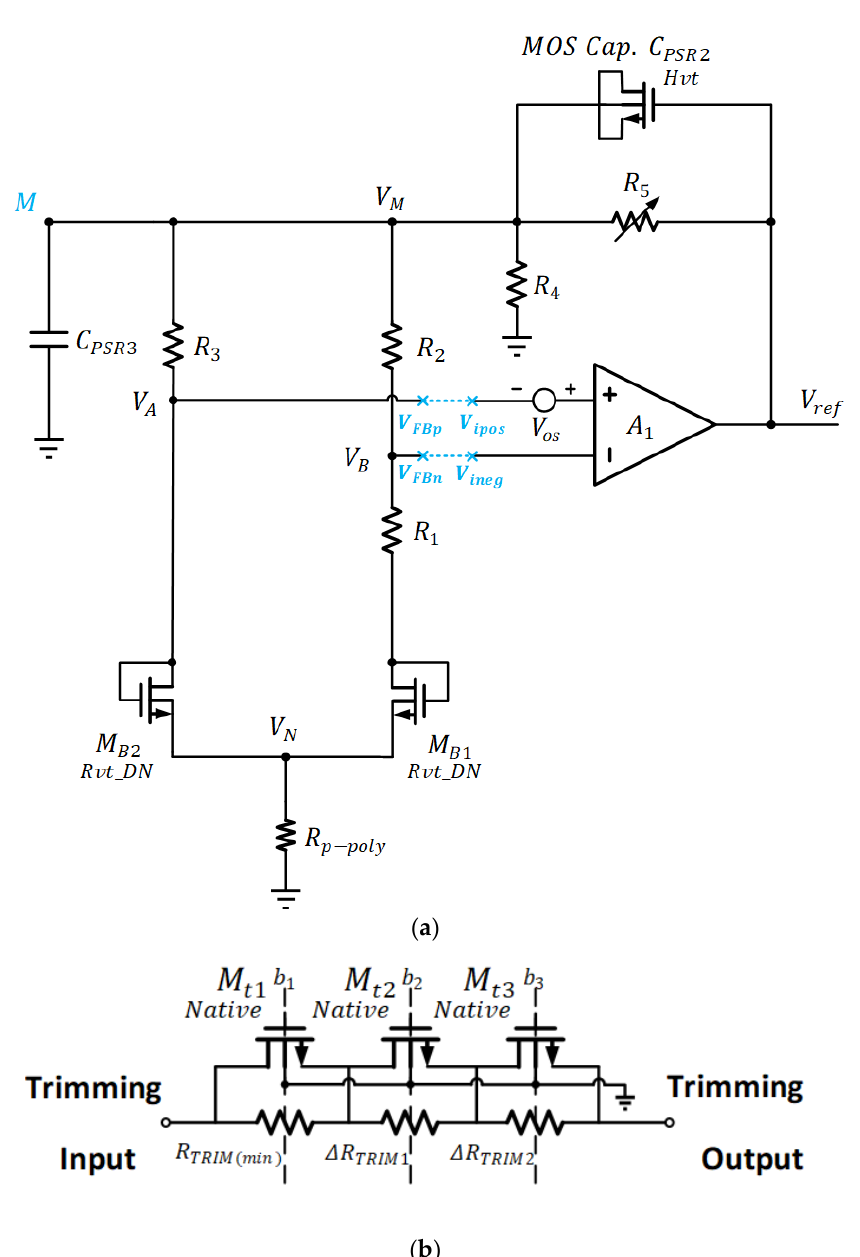
Figure 5. Proposed Voltage Reference Circuit with Second-Order Temperature Compensation: ( a ) Circuit Schematic ( b ) Binary-Weighted Trimming Circuit for 𝑅 5 . (𝑇 ) and 𝑅 (𝑇 ) in Figure 5a form the voltage scaling network. By adjusting the 𝑅 For M B 1 and M B 2 operating in the sub-threshold region and having different aspect 4 𝑟 5 𝑟 > ( W / L ) ratios, with ( W / L ) , it can be proved that the difference of gate-to-source 1 2 voltage [25] is given as: